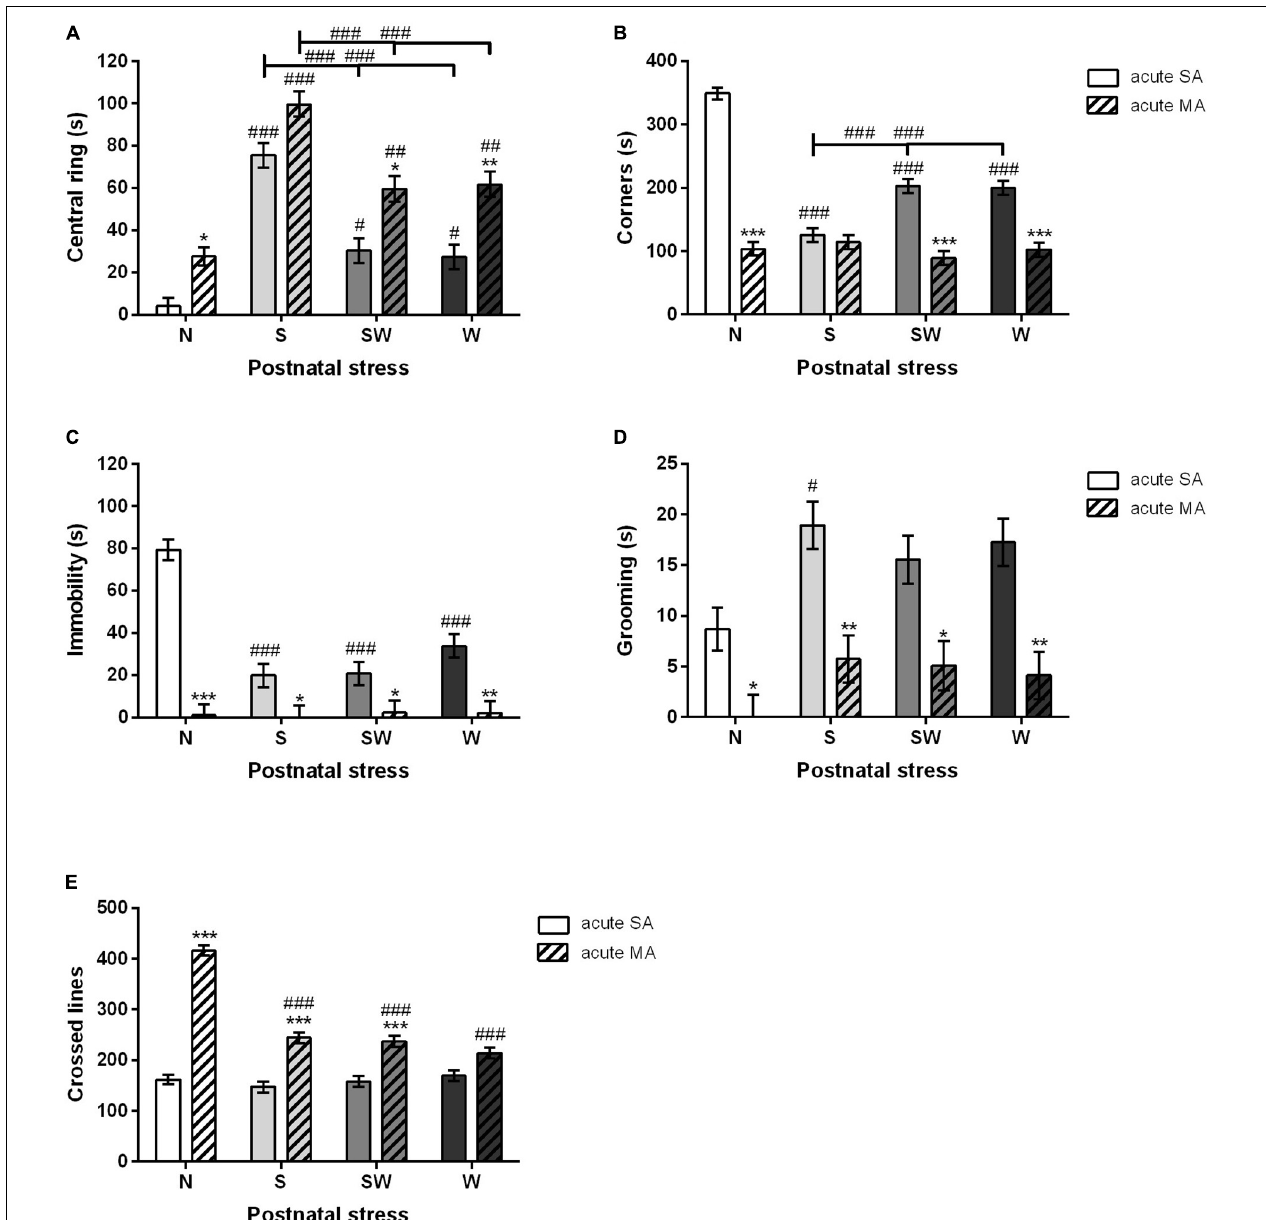
FIGURE 3 | The effect of postnatal stress and acute MA administration on anxiety- like behavior in the open field test. (A) Time spent in the central ring, (B) time spent in the corners, (C) time spent immobile, (D) grooming time, and (E) the number of lines crossed. Values are means ± SEM. N, non-stressed controls; S, maternal separation; W, maternal cold water swimming stress; SW, maternal separation plus maternal cold water swimming stress. Acute SA indicates a single direct saline injection prior to testing, and acute MA indicates a single direct methamphetamine injection prior to testing. * p < 0.05, ** p < 0.01, *** p < 0.001 significant difference in one group of x -axis. # p < 0.05, ## p < 0.01, ### p < 0.001 significant differences between the group in the legend and its N